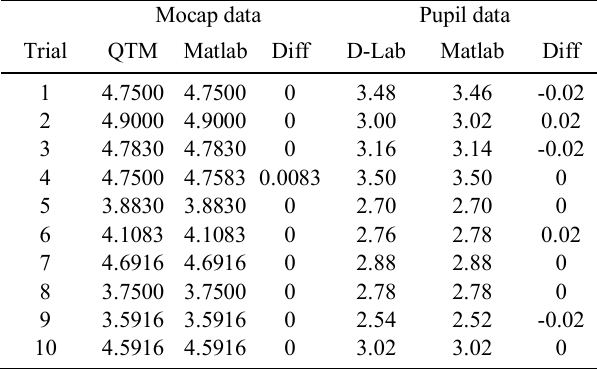
Table 1. “Ground truth” sync points (“QTM” and “D-Lab”) and computationally derived sync points (“Matlab”) as well as their respective difference (“Diff”). All values are in